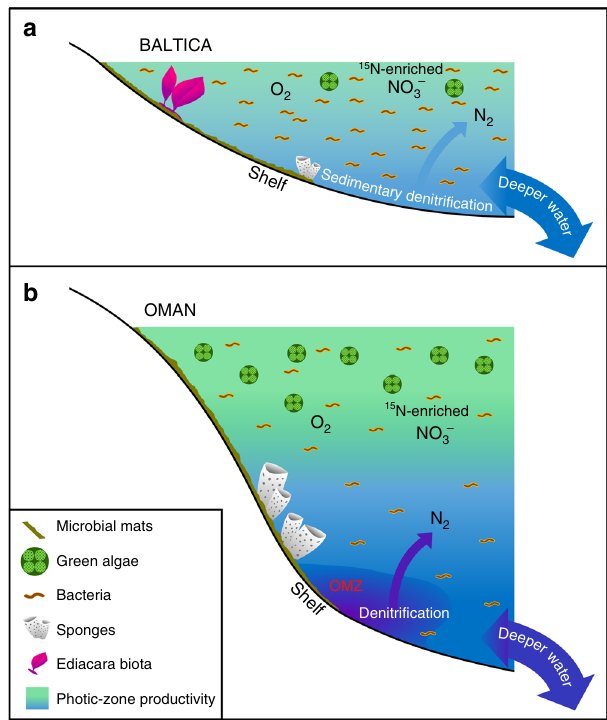
Fig. 3 Major differences in low-productivity vs. productive Ediacaran marine environments. Schematic diagrams are shown for a extensive oligotrophic and shallow-marine epicontinental basin margins of Baltica often dominated by bacterial productivity where Ediacara soft-bodied fauna fl ourished and where denitri fi cation and anammox likely were restricted to sediments; and b eutrophic and deeper-marine shelf settings of the South Oman Salt Basin, where green algae thrived as a primary producer and demosponges were abundant, but Ediacara soft-bodied fauna was not prominent (with Ediacara biota fossils also absent in correlative Ediacaran outcrops in northern Oman). On productive continental margins, denitri fi cation and anammox likely occurred in both the water column